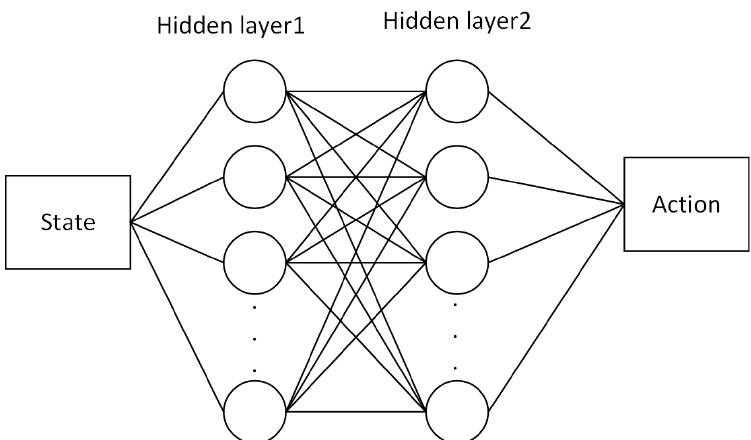
Figure 6. The schematic diagram of the current network.